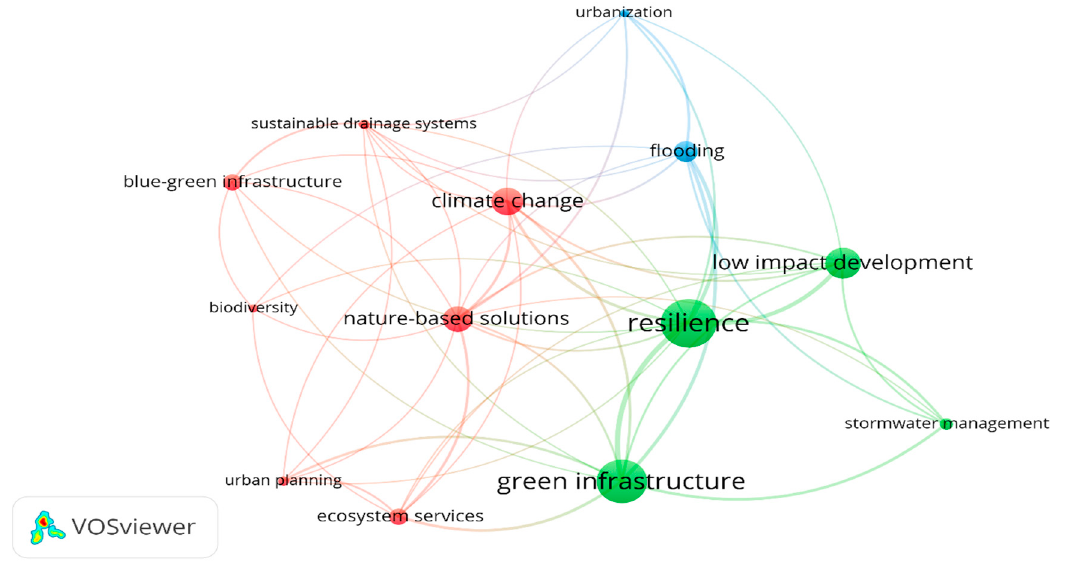
Figure 4. Keyword view and clusters in the reviewed literature from 2018 to 2022.